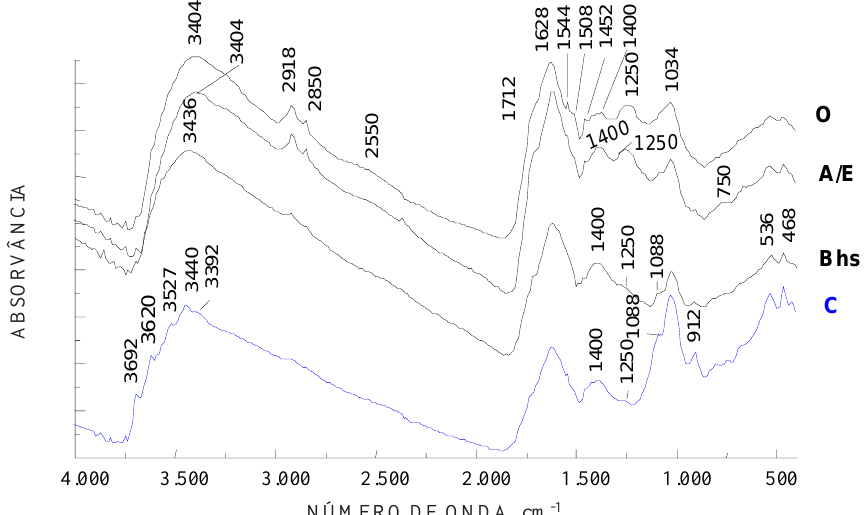
Figura 2. Espectros de absorvância no infravermelho dos ácidos húmicos não purificados, extraídos dos horizontes O, A + E, Bhs e C de um Podzol (perfil